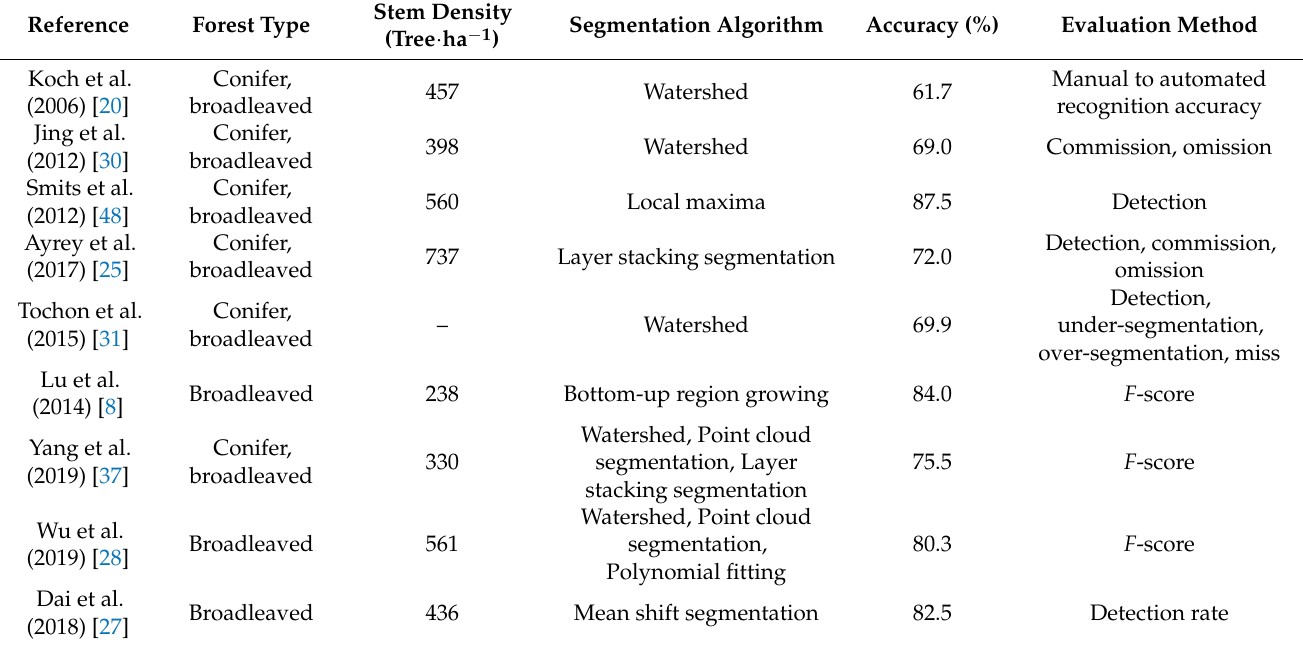
Table 5. Comparison of performance of individual tree segmentation using